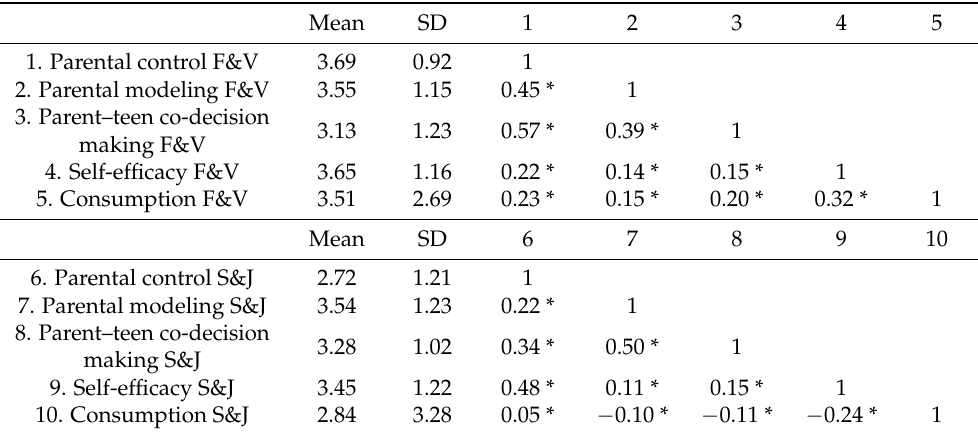
Table 2. Descriptive and correlation matrix among parental influence, self-efficacy, and F&V or S&J